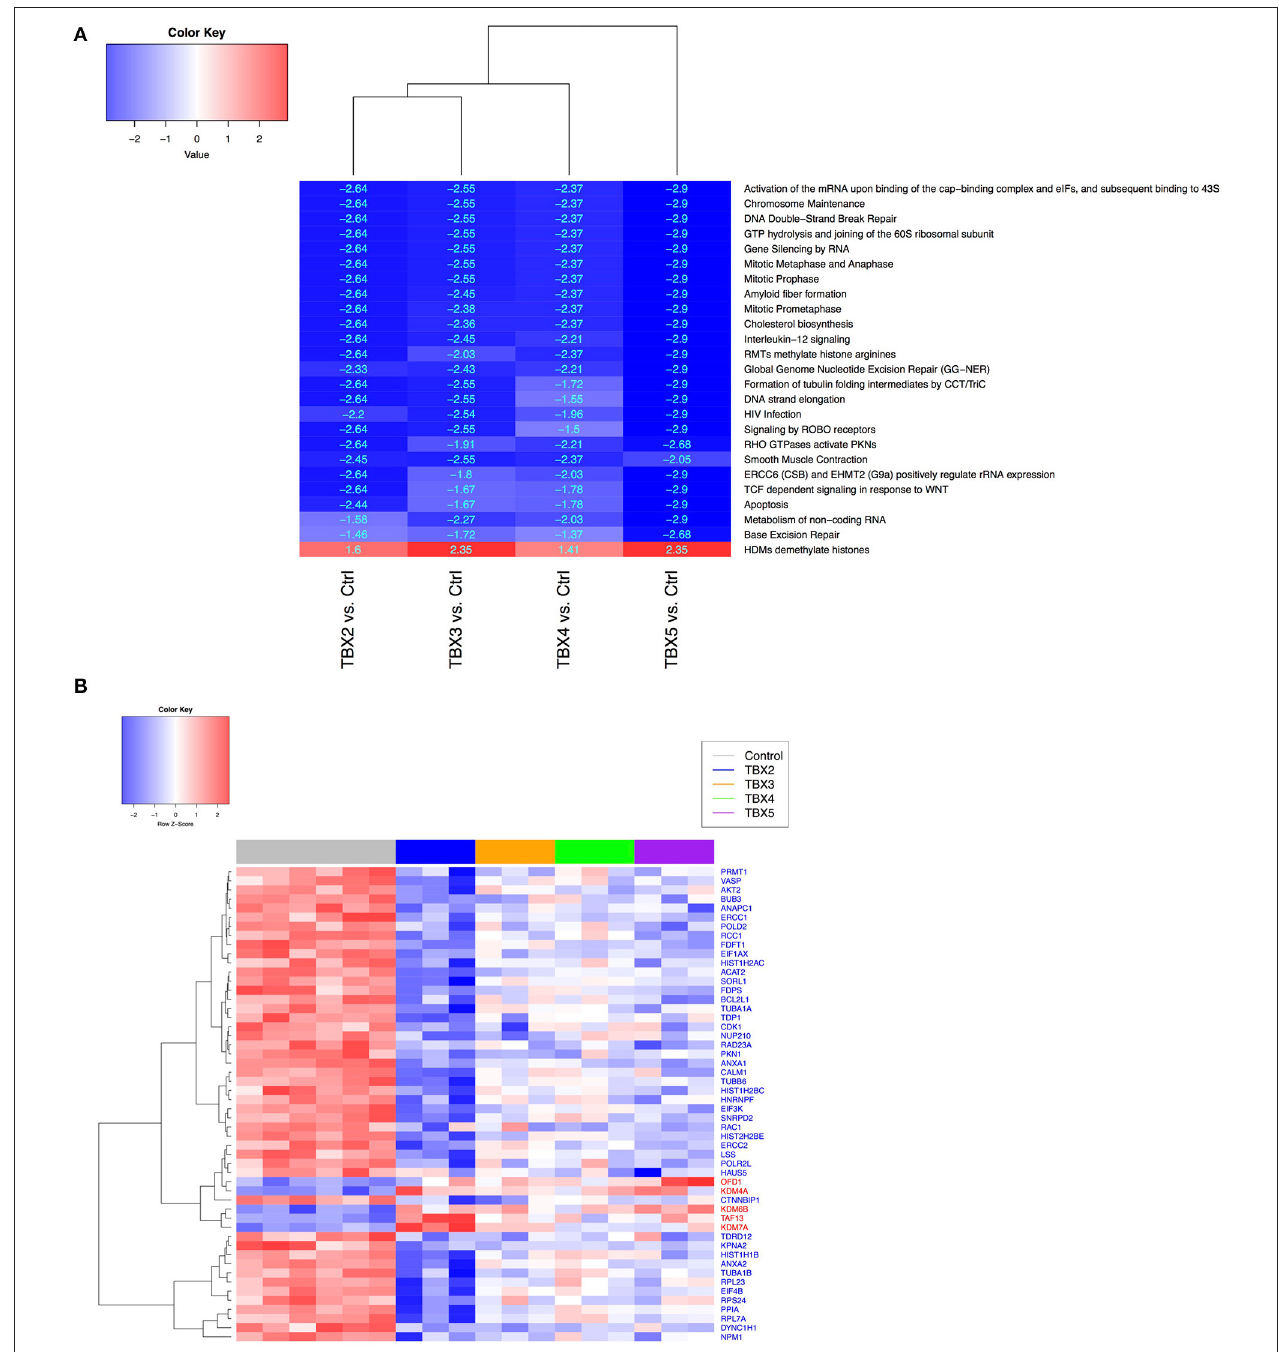
FIGURE 5 | Comparison of Reactome pathways (A) and gene expression data (B) between control H1299 and TBX construct groups. (A) Shared and significant Reactome pathways across all contrasts (TBX2-5 vs. controls, FDR < 0.05), from the gene set enrichment analysis (GSEA). Pathway labels: red ( N = 1 up-regulated), blue ( N = 24 down-regulated). For each pathway, numerical values represent the signed enrichment score (ES) multiplied by the negative log10 of the corresponding p -value (B) Heatmap showing the leading-edge genes ( N = 52), from the rank-based pathway enrichment analysis approach, extracted from (A) and differentially expressed in all TBX contrasts (FDR < 0.1 from DESeq analysis). Gene labels: red ( N = 5 up-regulated), blue ( N = 47 down-regulated).